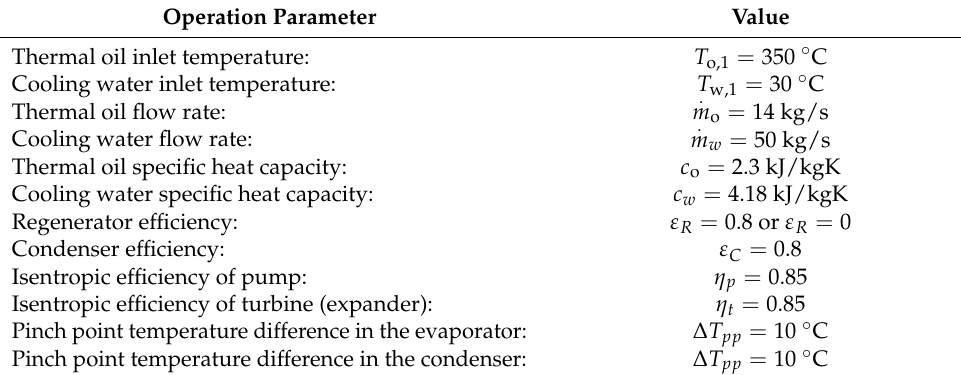
Table 3. Assumed modeling parameters of the ORC plant 1 . Operation Parameter